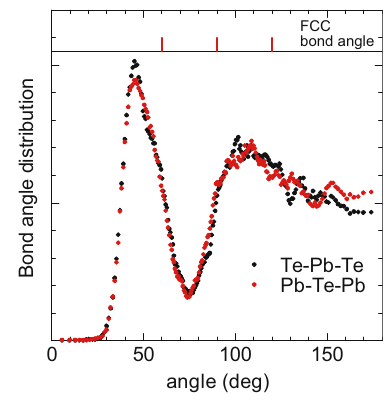
Figure 8: Bond angle distributions in liquid Pb 0.5 Te 0.5 obtained from three dimensional con fi guration of Pb 0.5 Te 0.5 by using